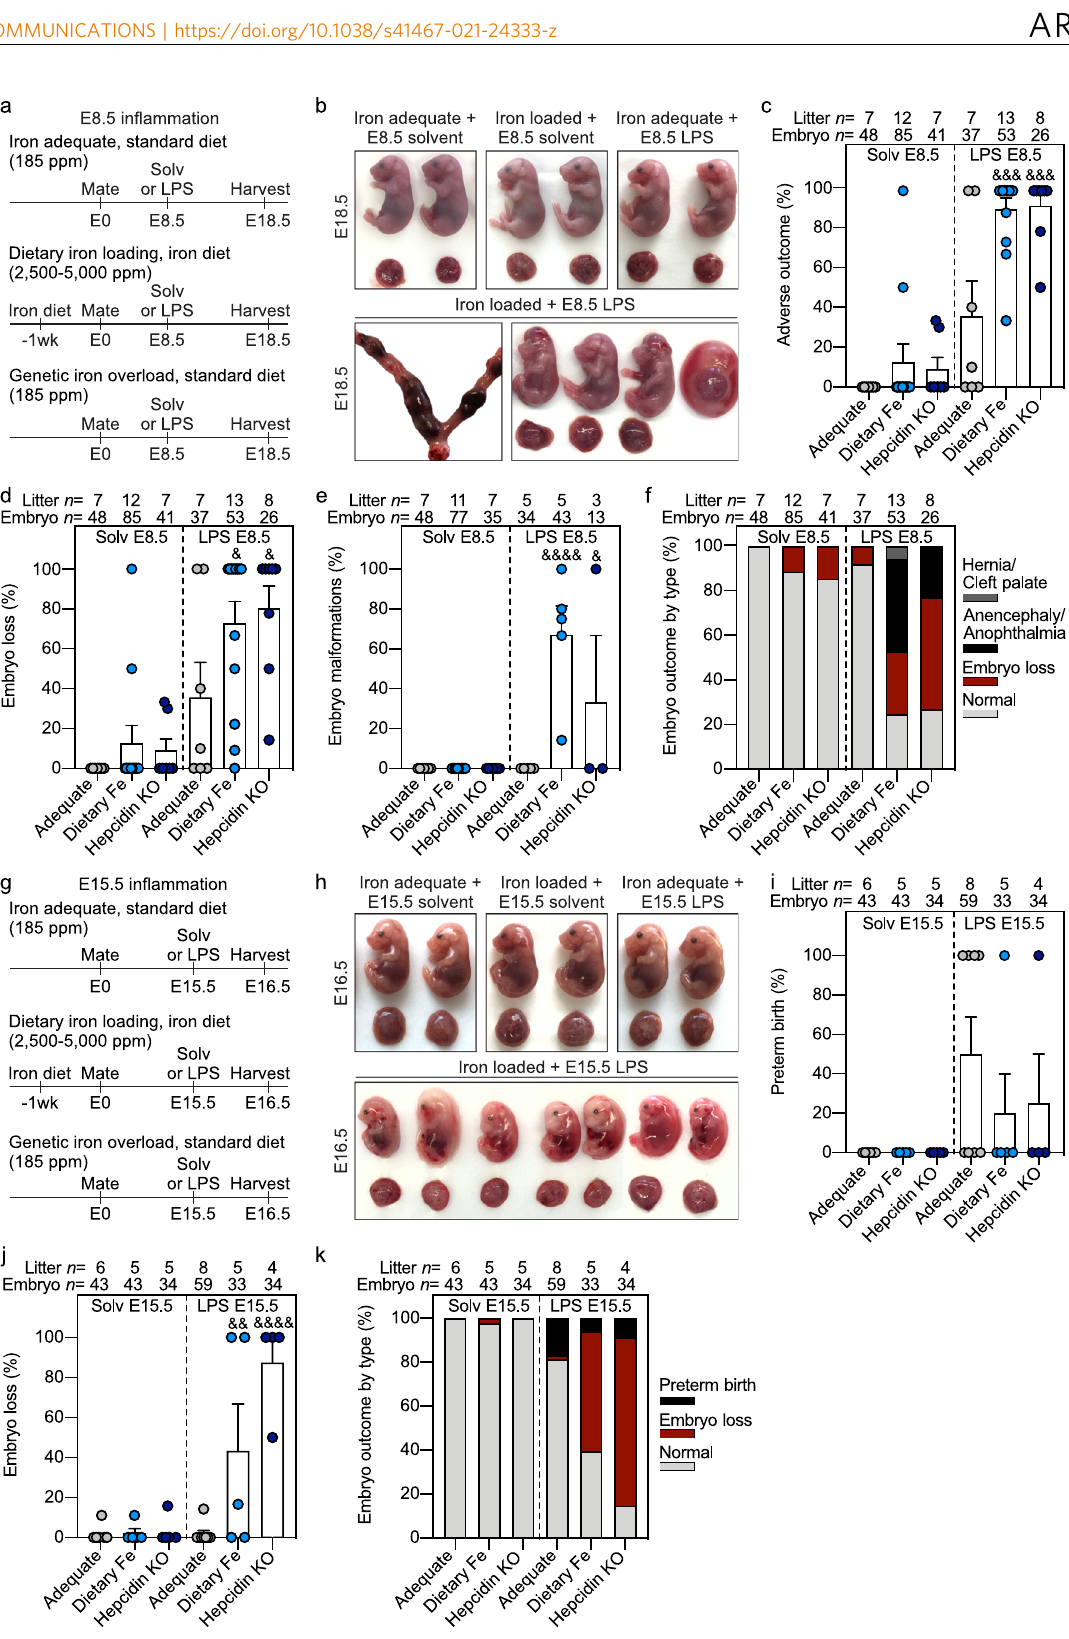
embryo weights represent healthy and malformed embryos but exclude resorbing embryos in which weights were not accurately obtained. Since E8.5 LPS injection caused embryo loss in iron-loaded dams, this limited the availability of embryo tissue for analysis. We thus injected LPS or solvent on E15.5 and analyzed outcomes